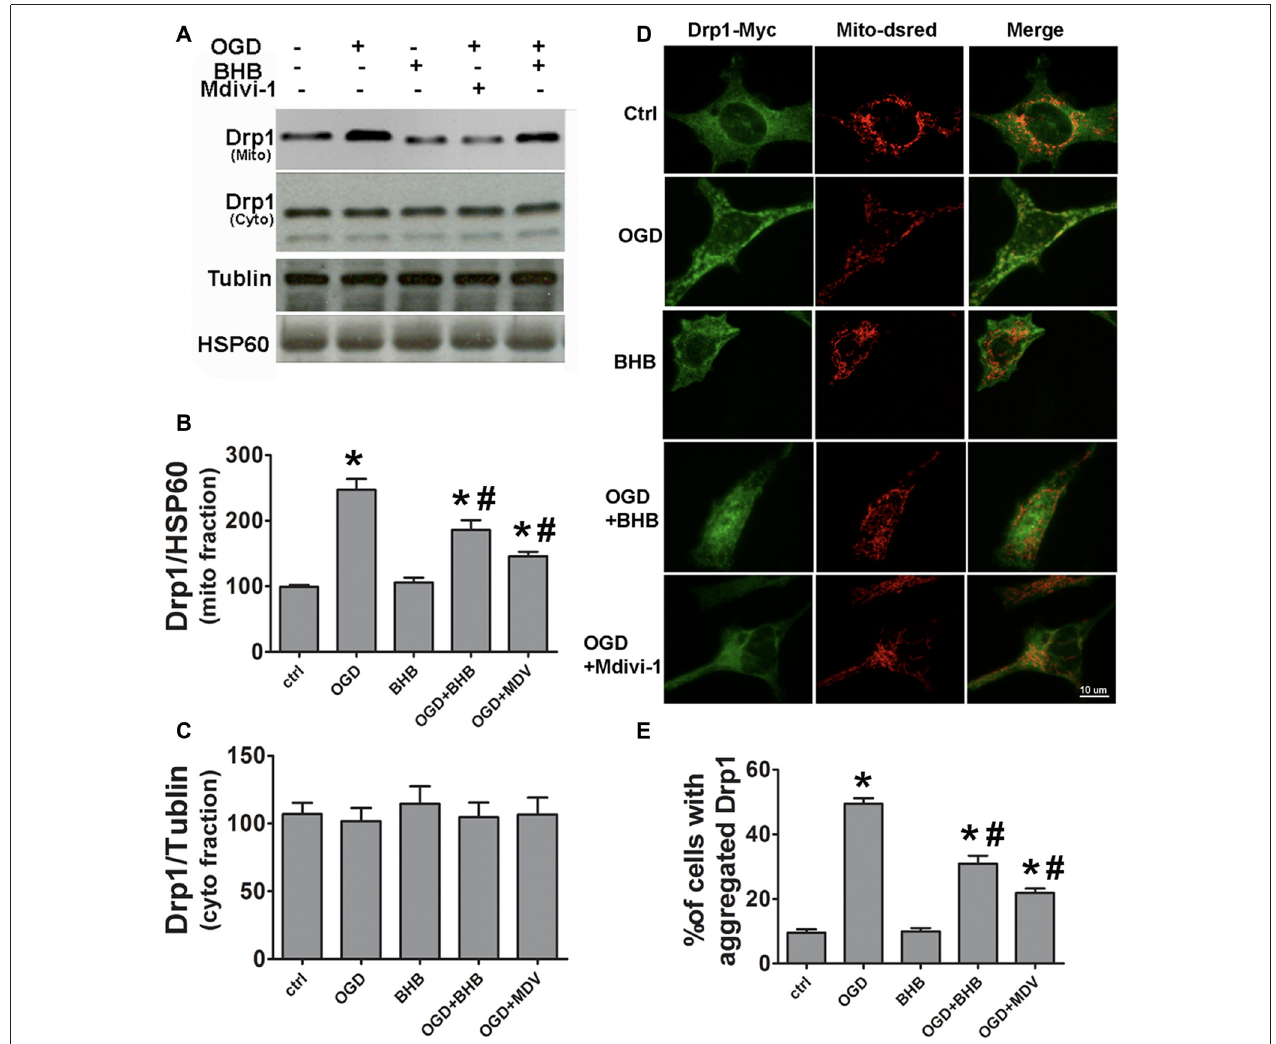
FIGURE 5 | BHB and mdivi-1 prevented dynamin-related protein 1 (Drp1) mitochondrial translocation after OGD/R. (A–C) Protein expression of mitochondrial fission protein Drp1 in the mitochondria and cytoplasm was detected by Western blotting. Representative blots from six independent experiments with similar results are shown. (D) SH-SY-5Y cells were co-transfected with DsRed-Mito and Drp1-myc. Scale bar: 10 µ m. (E) Quantification of aggregated Drp1 in cells subjected to different treatments. Data are shown as mean ± SEM; ∗ P < 0.01 vs. Ctrl group, # P < 0.05 vs. OGD group.